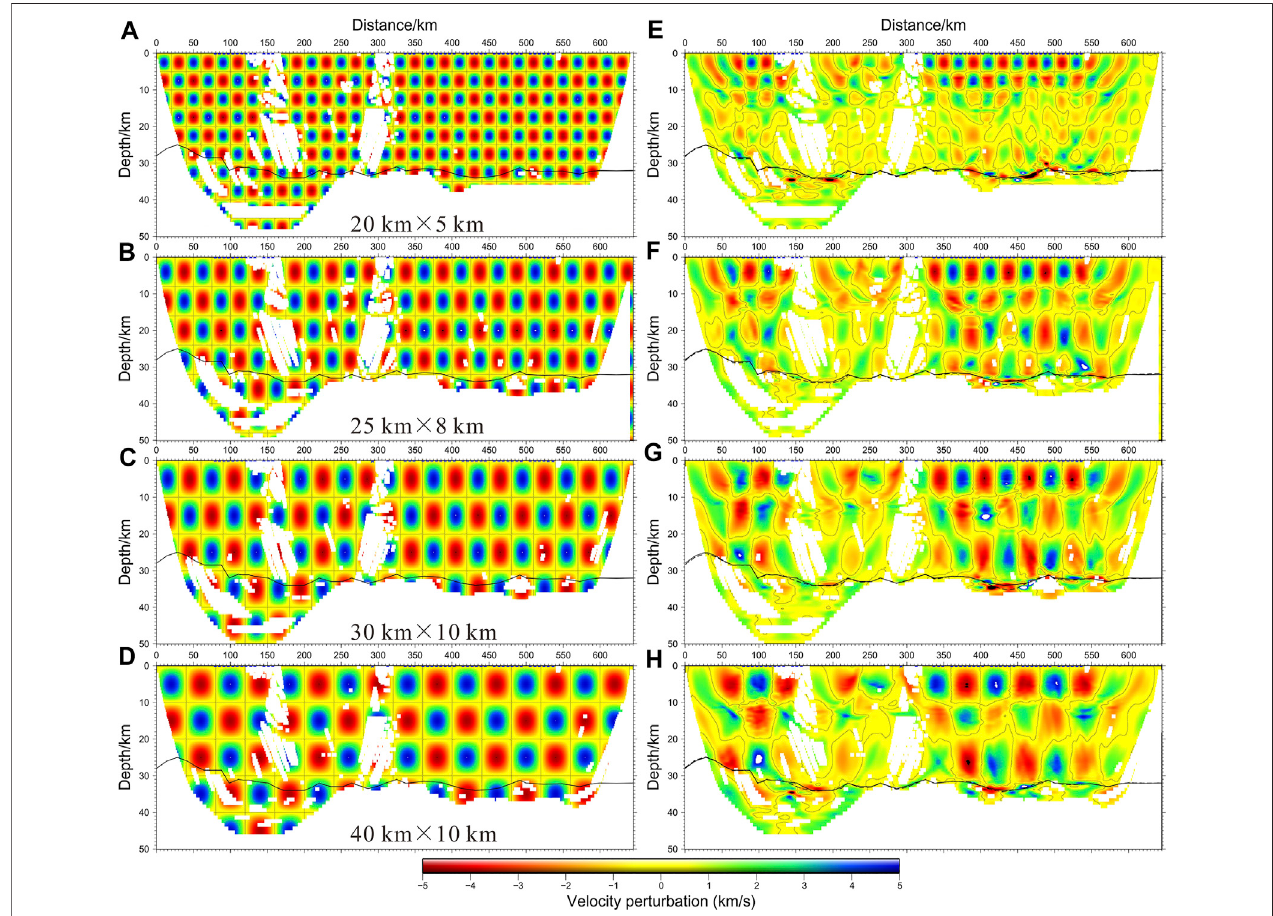
FIGURE 8 | Checkerboard tests for the tomography model of Line 2013. The input checkerboard patterns (left) and the corresponding output results (right) have the checkerboard sizes of 20 × 5 km (A,E) , 25 × 8 km (B,F) , 30 × 10 km (C,G) , and 40 × 10 km (D,H) , respectively. Regions without ray coverage are shown in white.